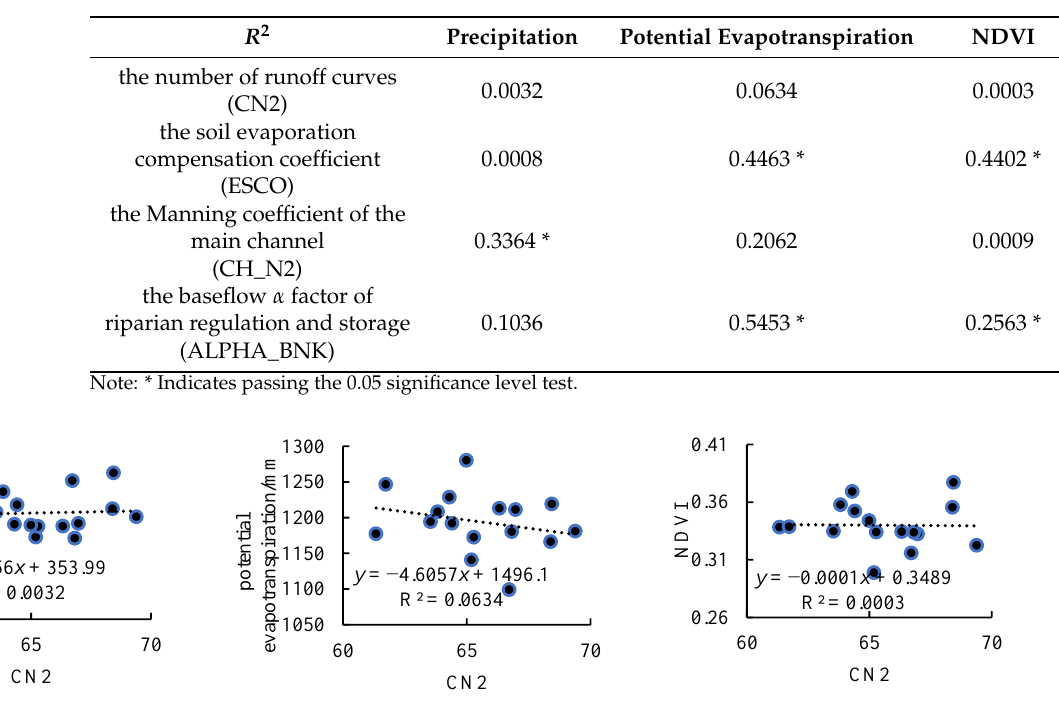
Table 3. The R 2 of each parameter with precipitation, potential evapotranspiration and NDVI.